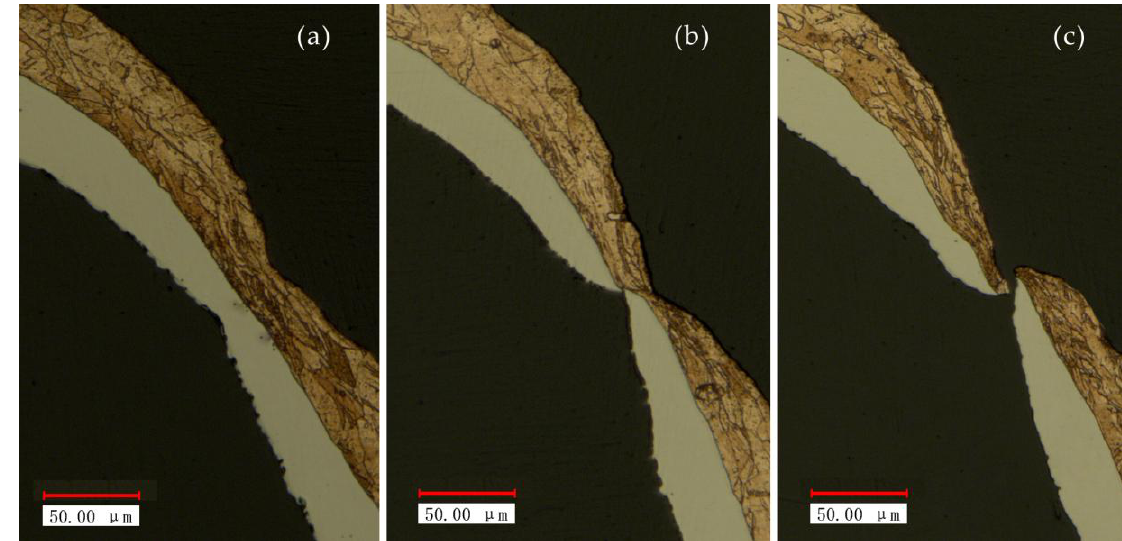
Figure 12. The microstructure of the fracture process at 25 °C and different energy: ( a ) 720 mJ, ( b ) 1080 mJ and ( c ) 1800 mJ.